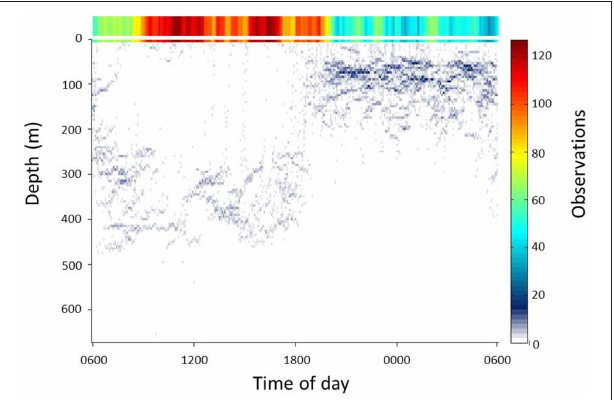
FIGURE 3 | Summary of vertical movements of whale sharks over a 24h cycle during times when the sharks resided in the open ocean (water depths > 200m). Observations are color-coded relative to the total number of observations within 5m depth intervals and each 5min period of the 24h cycle. The right axis shows the scale for the color coding. Observations within the top 5m of the water column are shown enlarged at the top of the plot.